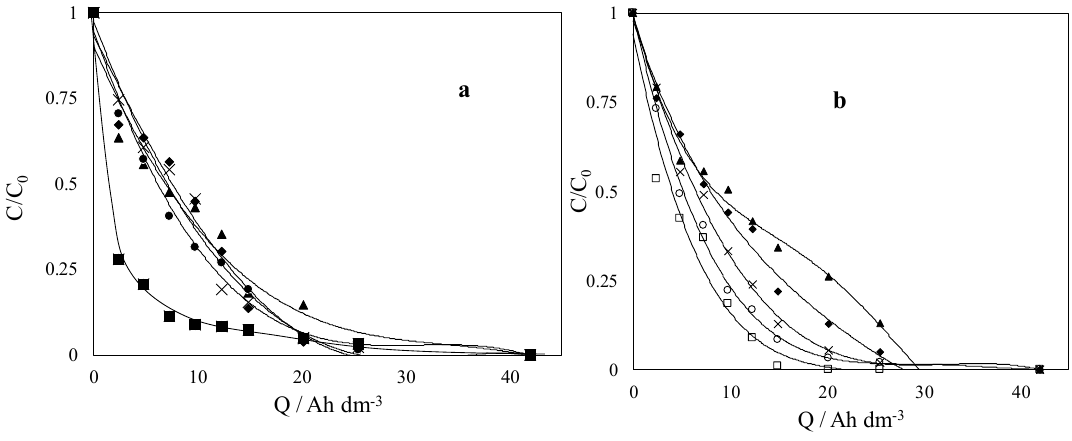
Figure 7. E ff ect of [SDS] / soil ratio. ( (cid:78) ) 0.5; ( (cid:7) ) 2.5; ( • ) 5; ( × ) 12.5; ( (cid:4) ) 25, on the degradation profiles Figure 7. Effect of [SDS]/soil ratio. ( ▲ ) 0.5; ( ♦ ) 2.5; ( ● ) 5; (×) 12.5; ( ■ ) 25, on the degradation profiles of of ( a ) SDS and ( b ) atrazine during the CDEO treatment of the SW e ffl uent at a current density of ( a ) SDS and ( b ) atrazine during the CDEO treatment of the SW effluent at a current density of 30 mA 30 mA cm − 2 . Reprinted with the permission of cm − 2 . Reprinted with the permission of [122].